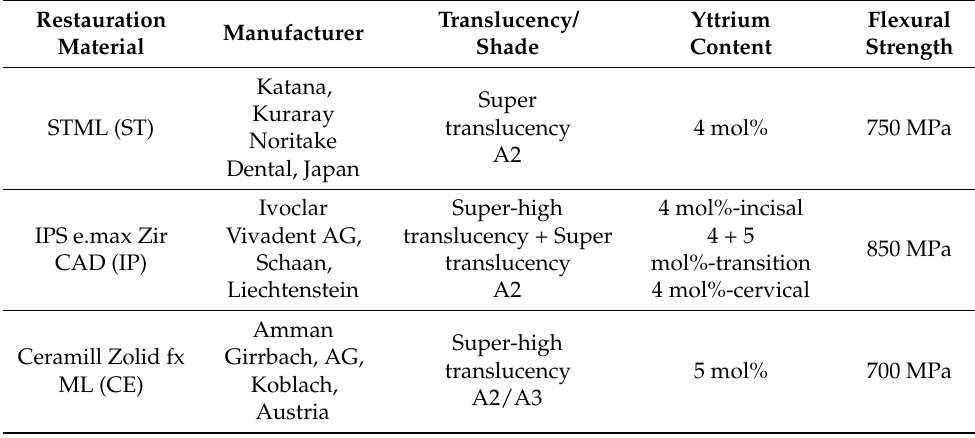
Table 1. Properties of the materials taken into the study [49–51].